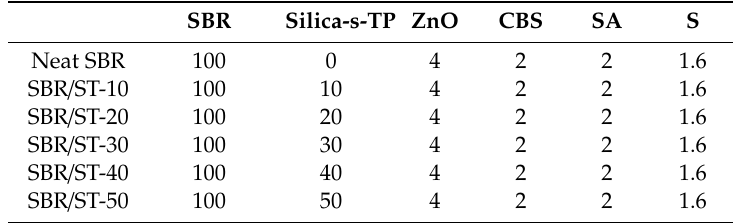
Table 1. Composition of SBR/silica-s-TP composites (phr).